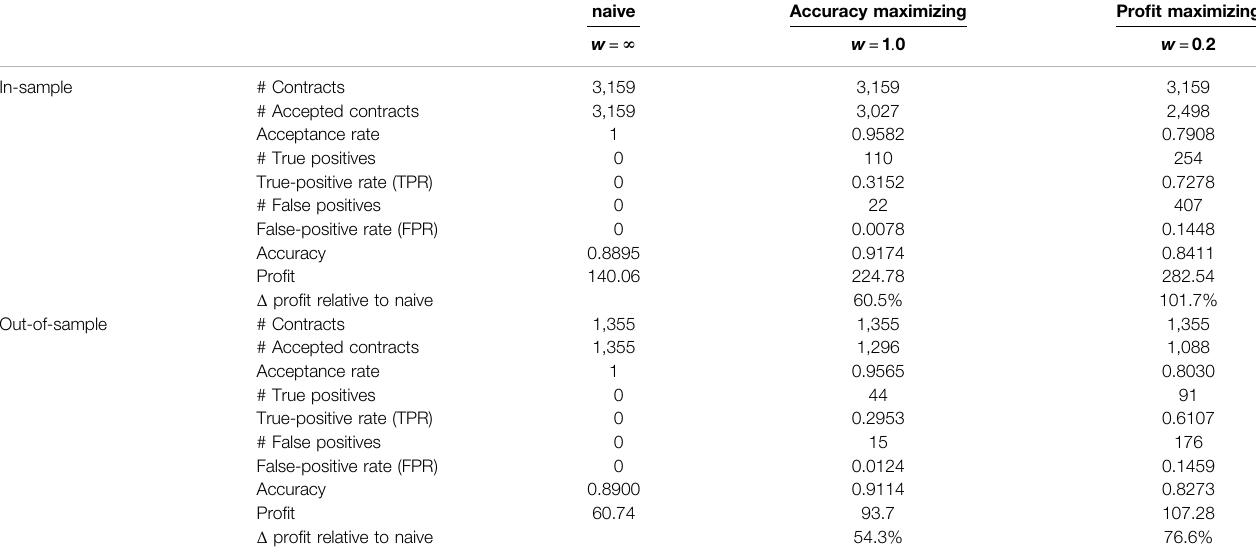
TABLE 4 | Overview of the in- and out-of-sample performance fi gures of decision tree models with different weightings w of the non-defaulting contracts. naive Accuracy maximizing Pro fi t maximizing w = ‘ w = 1 . 0 w = 0 . 2 In-sample #